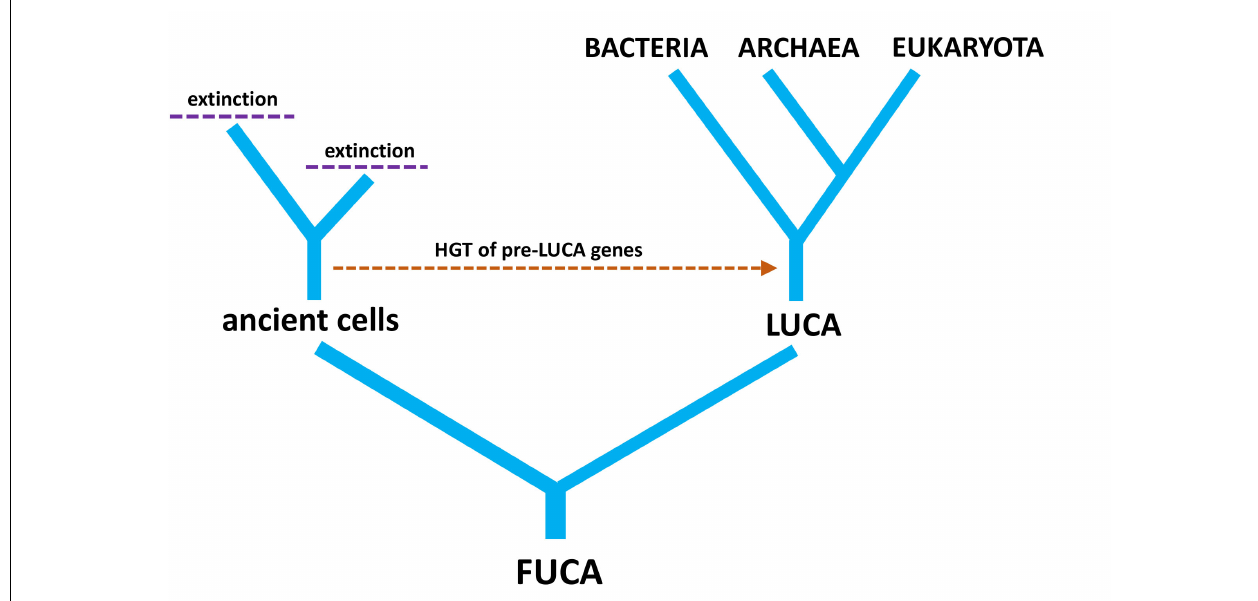
FIGURE 4 | A simple tree diagram showing the relationship between LUCA (last universal common ancestor) and FUCA (first universal cellular ancestor). The hypothetical transfer of pre-LUCA genes from ancient cells into post-LUCA genomes is also depicted, along with extinction events of cellular lineages that have no modern